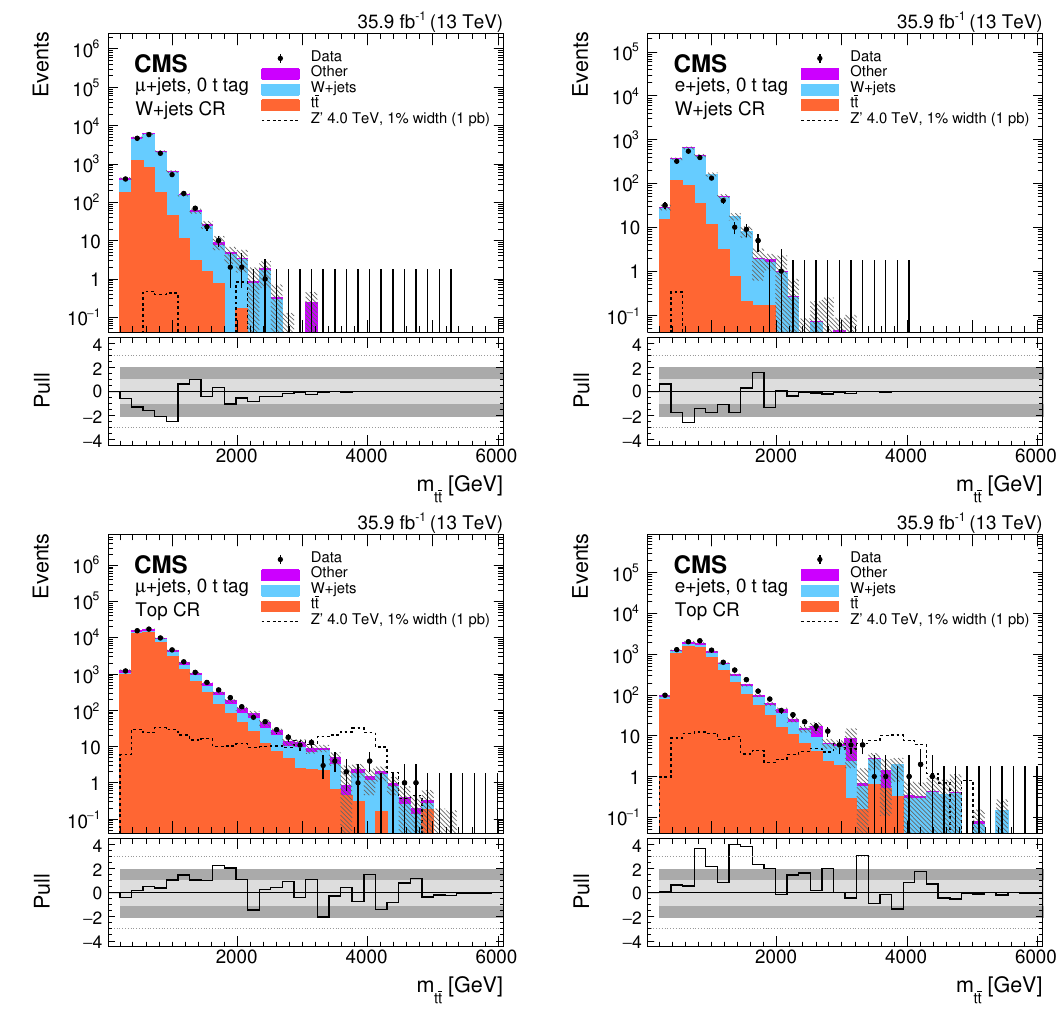
Figure 10 . Distributions of m for the single-lepton channel CR1 (upper) and CR2 (lower) for tt the muon (left) and electron (right) categories. The contribution expected from a 4 TeV Z 0 boson, with a relative width of 1%, is shown normalized to a cross section of 1 pb. The hatched band on the simulation represents the uncertainty in the background prediction. The lower panel in each plot shows the pull of each histogram bin from the SM prediction. The light (dark) gray band represents a pull of one (two) s.d. from the predicted